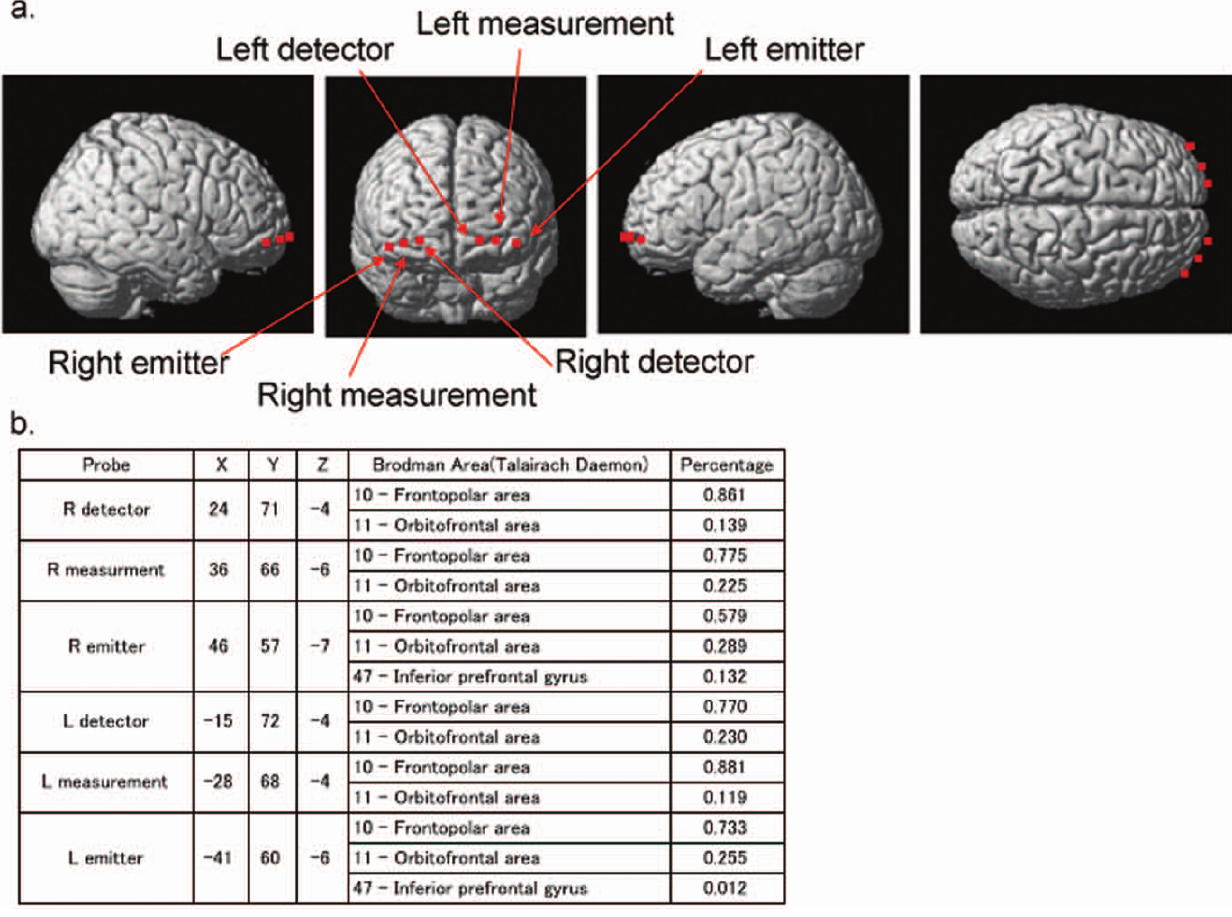
Figure 1. The probe positions and the measurement areas. a:The correspondence of the probe positions and the measurement areas on the cerebral cortex. b: The locations of NIRO probe were probabilistically estimated and anatomically labeled in the standard brain space (Brodmann’s Area) according to [39].